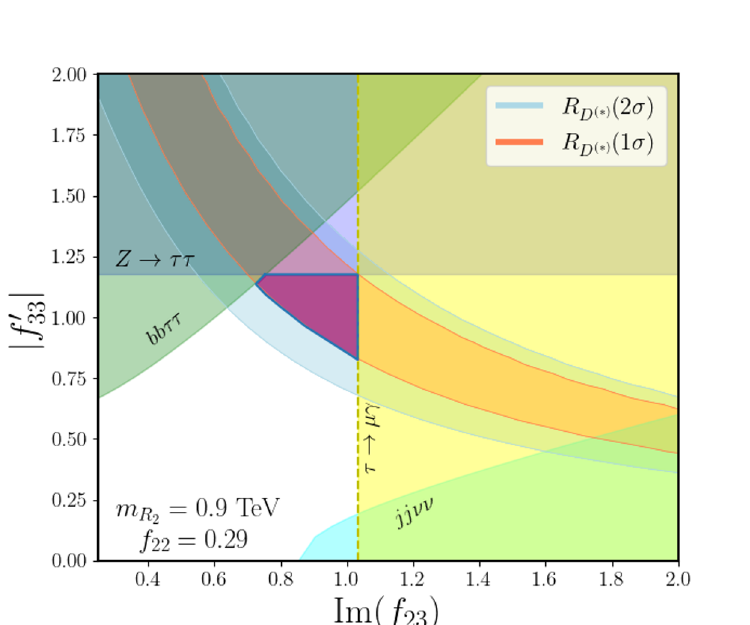
JHEP03(2021)179 Figure 9 . 1 σ (light red) and 2 σ (light blue) allowed range for R in the relevant Yukawa coupling D ( ? ) plane, with the R 2 LQ mass at 900 GeV and with a fixed f 22 = 0 . 29 . The horizontal purple band is from the Z → ττ constraint. The curved green band and cyan bands respectively represent exclusion from LQ pair production in pp → bbττ and pp → jjνν channels at LHC. The vertical yellow band corresponds to the exclusion from LFV decay τ → µγ . The dark purple shaded box represents the 1 σ allowed region for R that is consistent with all the constraints in this model. D ( ? ) minimization to get neutrino oscillation fit, we choose the f coupling purely imaginary, 23 as shown in figure